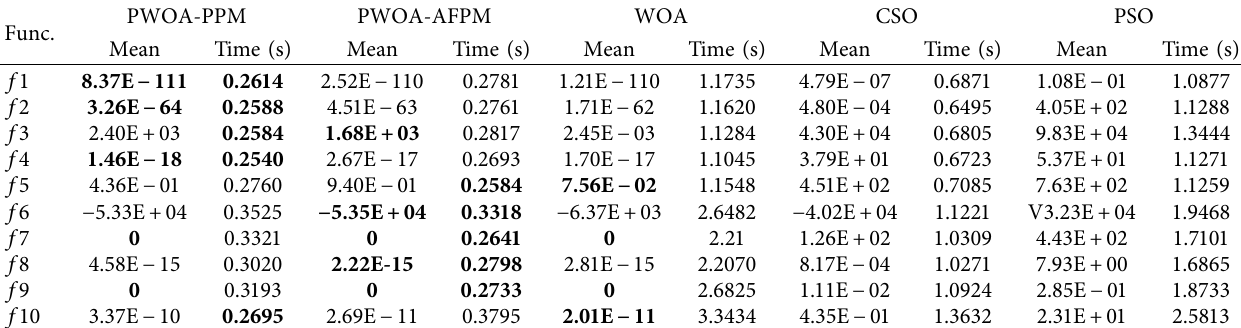
Table 3: Comparison between the proposed algorithms and the state-of-the-art algorithms (128D).